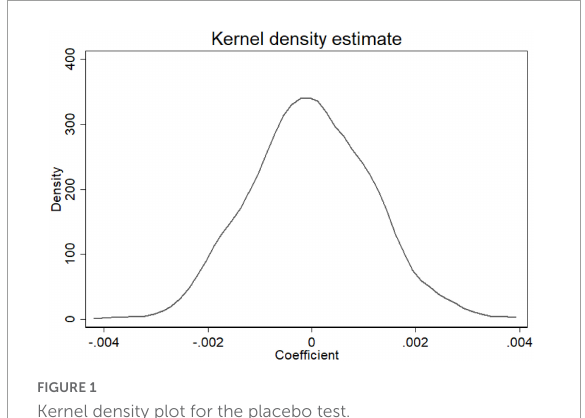
FIGURE1 Kernel density plot for the placebo test.